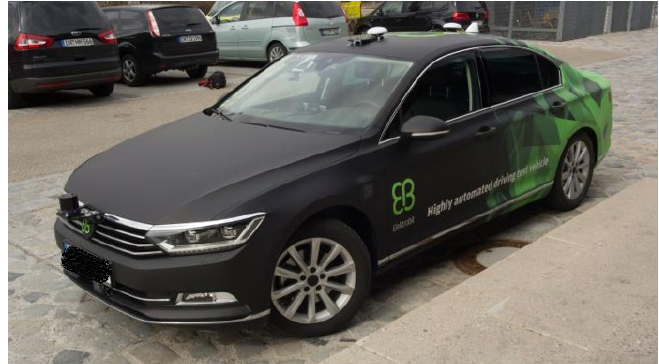
Figure 12. Test vehicle used for data acquisition and testing for the Most Probable Path (MPP) AI Inference